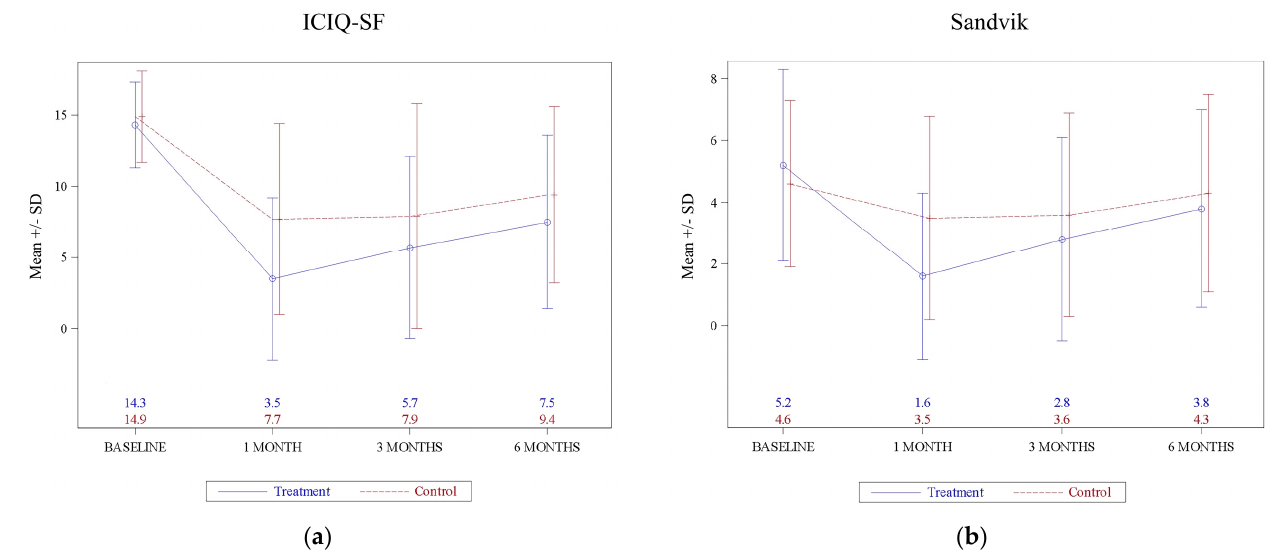
Figure 2. ICIQ-SF and Sandvik score evolution for active treatment and placebo during treatment and follow-up: ( a ) ICIQ-SF; ( b ) Sandvik. Table 3. Mean ± SD values obtained by self-assessed questionnaires performed during the study.